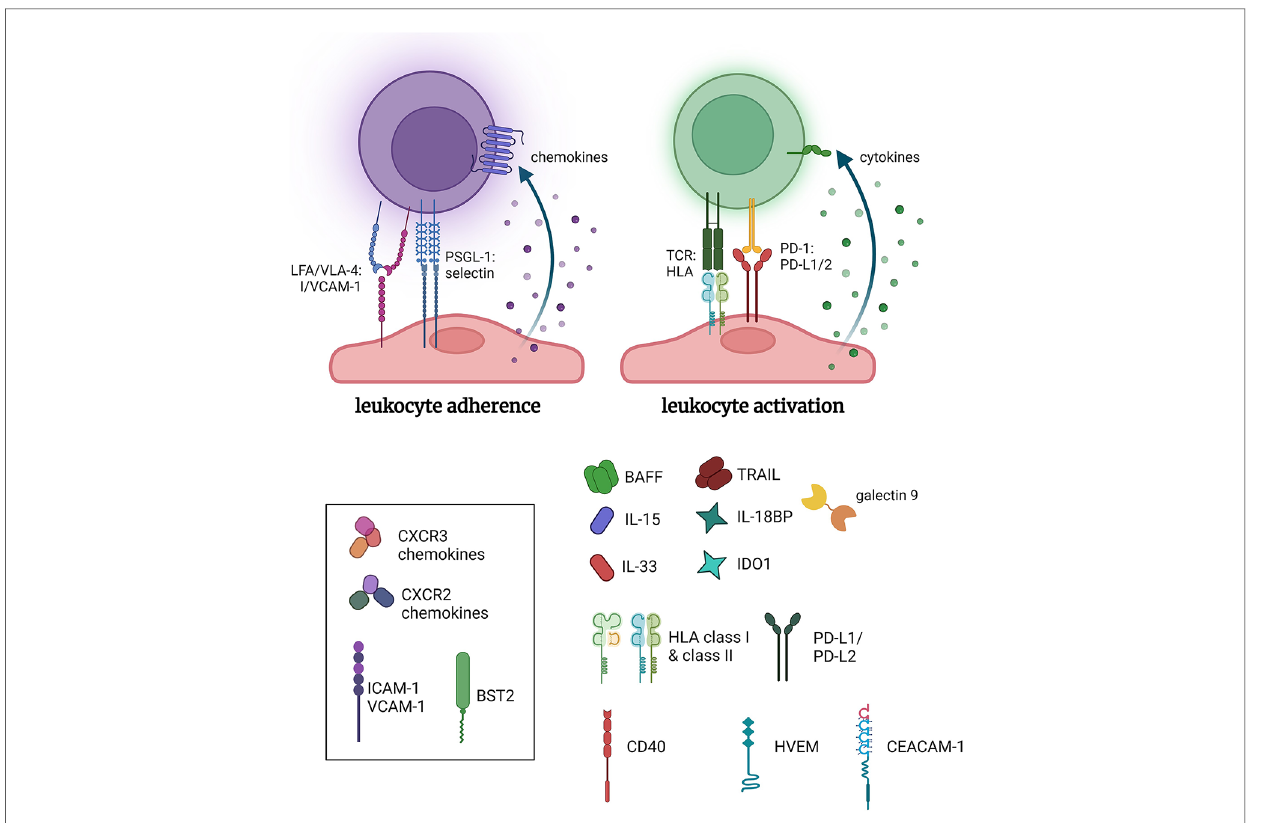
FIGURE 1 Pro-in fl ammatory functions of endothelial cells. Endothelial cells inducibly express a host of adhesion molecules and chemokines that promote leukocyte recruitment. Additionally, select stimuli, such as IFN γ , cause conditional expression of HLA molecules including HLA class II, and several costimulatory molecules and cytokines, which collectively can in fl uence the activation of allogeneic leukocytes. Made in biorender